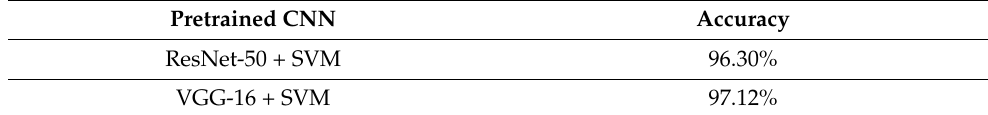
Table 5. Accuracy results of ResNet-50 with SVM and VGG-16 with SVM.